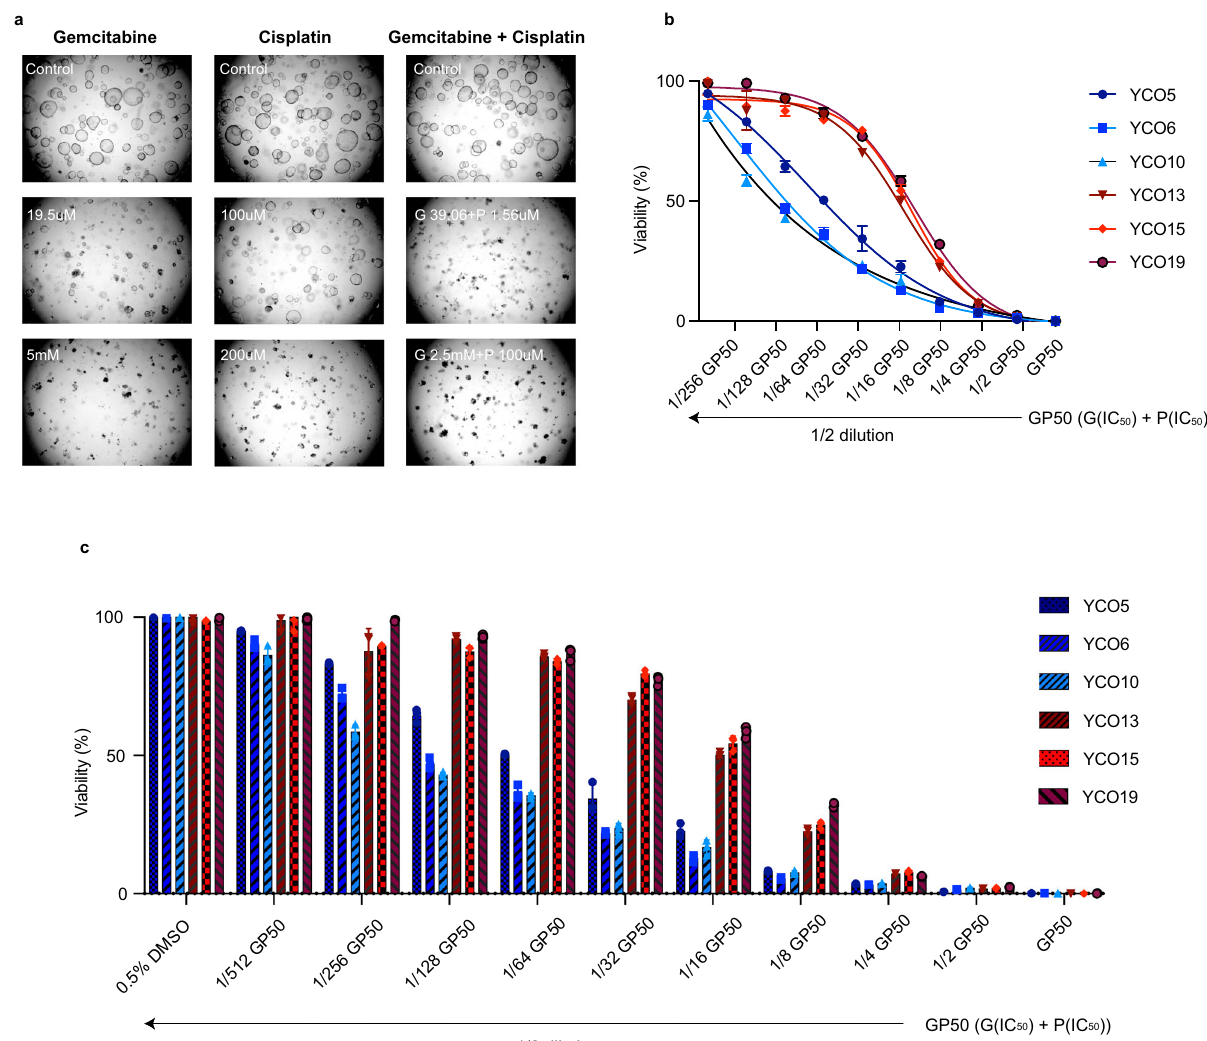
Fig. 5 | Chemotherapy responses of patients and patient-derived tumor orga- noids. Patient-derived organoids show duct-type – speci fi c difference in cytotoxic drug sensitivity pro fi les. Scale bar: 200 µ m. a Representative bright- fi eld micro- scopy images of organoids ( n =6, 3 samples in LD- and SD-type, respectively). b Viability test showing differences in sensitivity to combined treatment with gemcitabine and cisplatin between LD (red) and SD (blue) cancer organoids. n =6